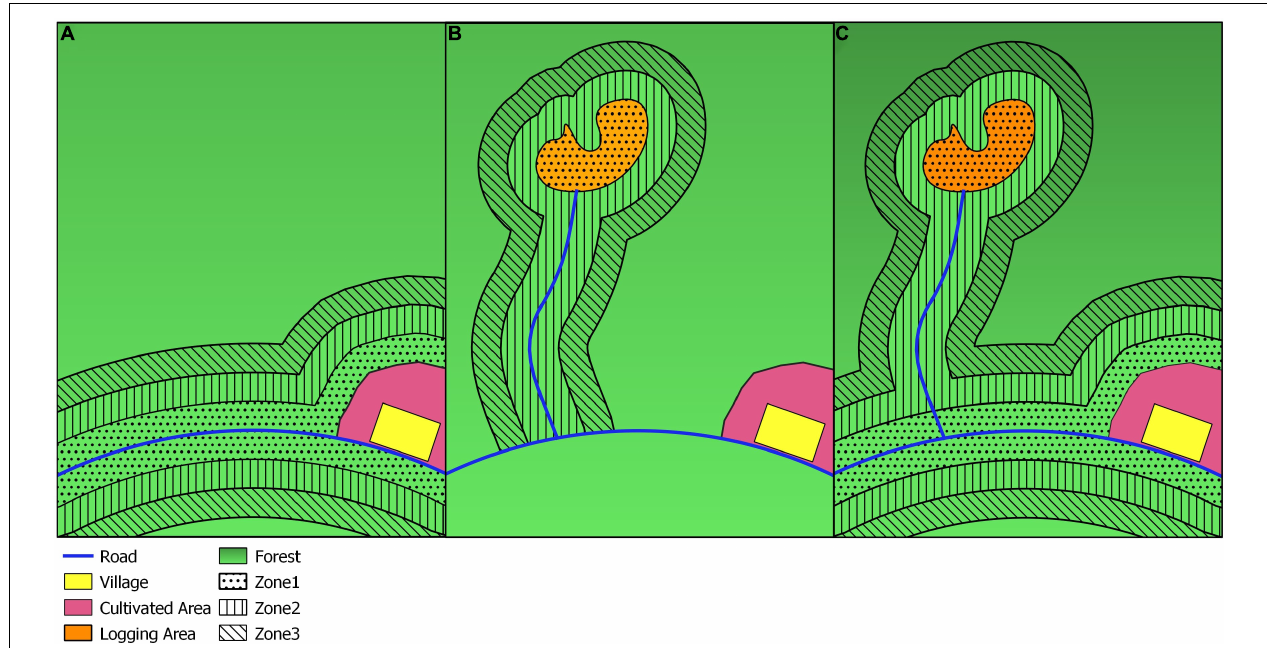
FIGURE 1 | Diagram of stratified sampling design, showing sampling zone 1 (points), zone 2 (vertical hash), and zone 3 (diagonal hash). Sampling intensity decreases from zone 1 to zone 3. (A) Degradation risk stratification – showing higher sampling along road and close to community where there is a higher risk of degradation. (B) Local Knowledge stratification – showing higher sampling within logging area, along logging access road and surrounding logging area. (C) Combination stratification – using a combination of strategy A and B to stratify sample